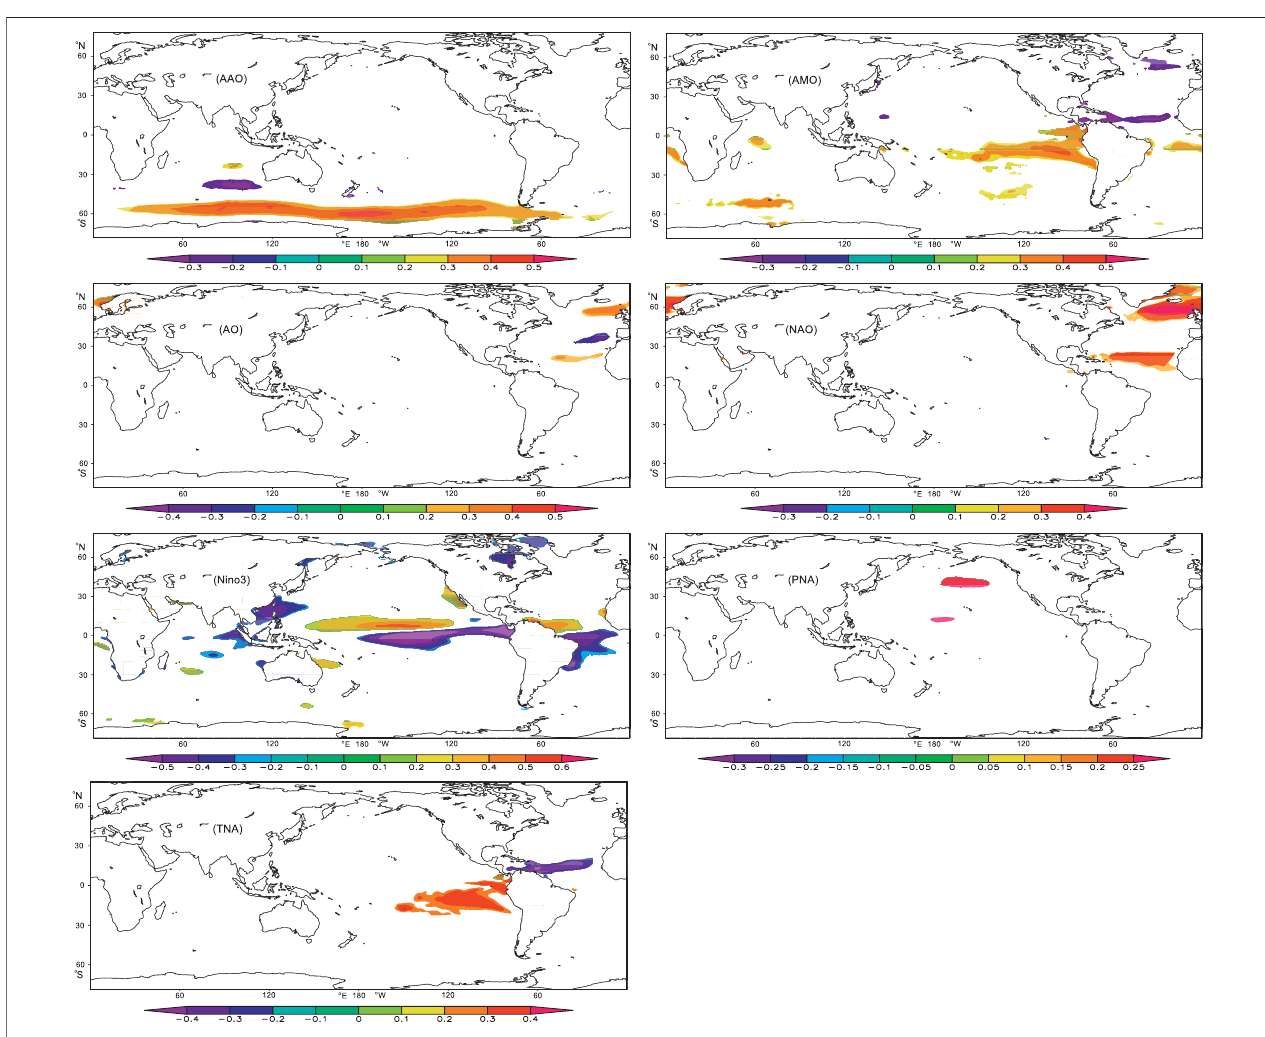
FIGURE 12 | Correlations between WPD and AAO, WPD and AMO, WPD and AO, WPD and NAO, WPD and nino3, WPD and PNA, and WPD and TNA.